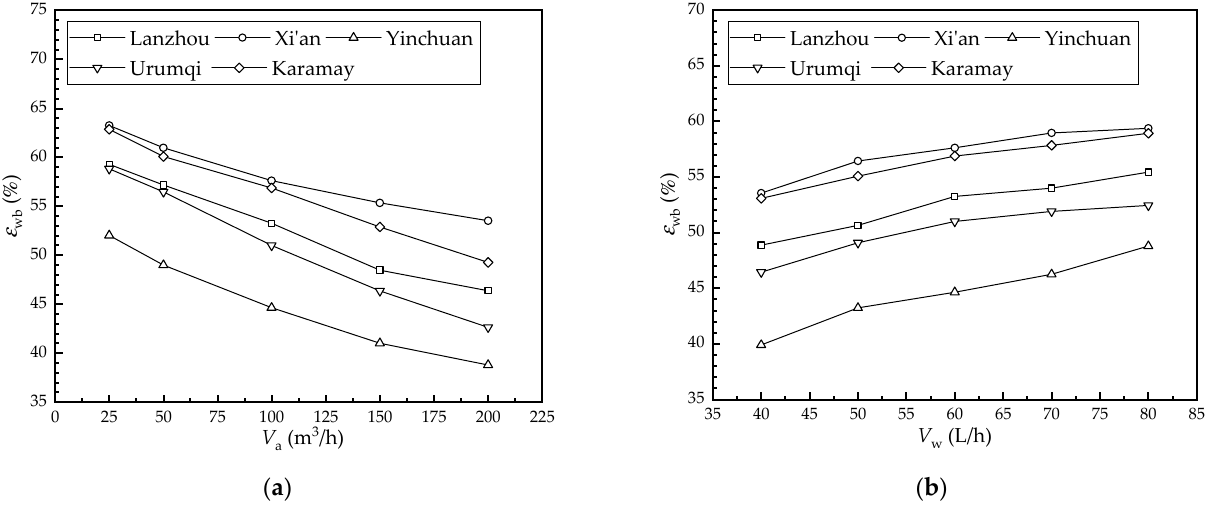
Figure 8. Effect of the flow rate on the wet-bulb efficiency in each city: ( a ) air flow rate; ( b ) water flow rate.